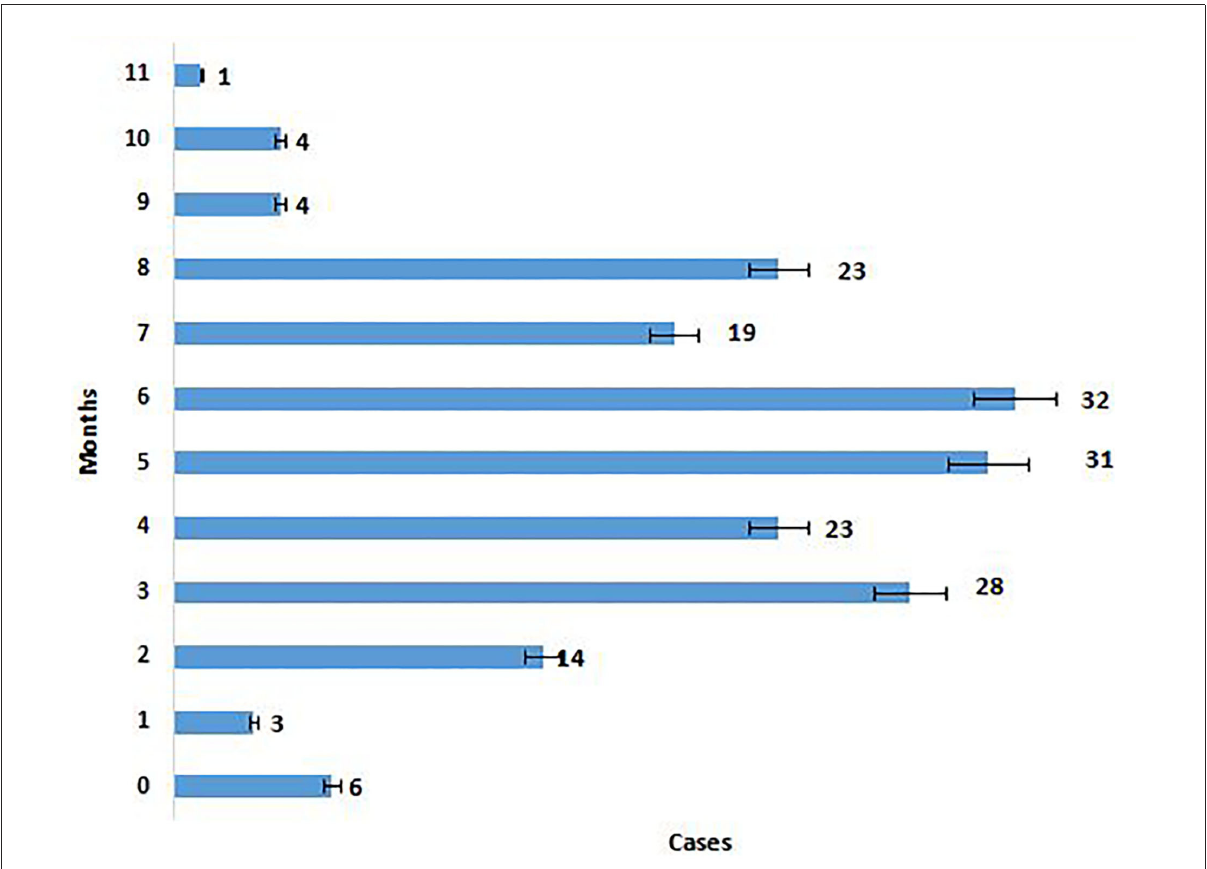
FIGURE7 Months elapsed since vaccination and PCR